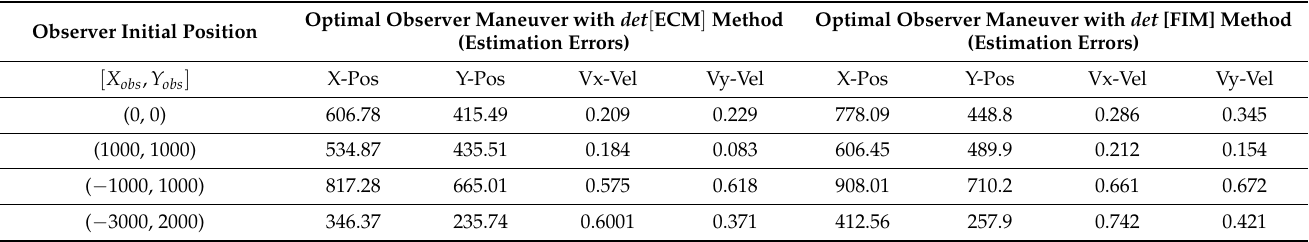
Table 3. Comparison of UKF based Optimal Observer Maneuver using ECM and FIM